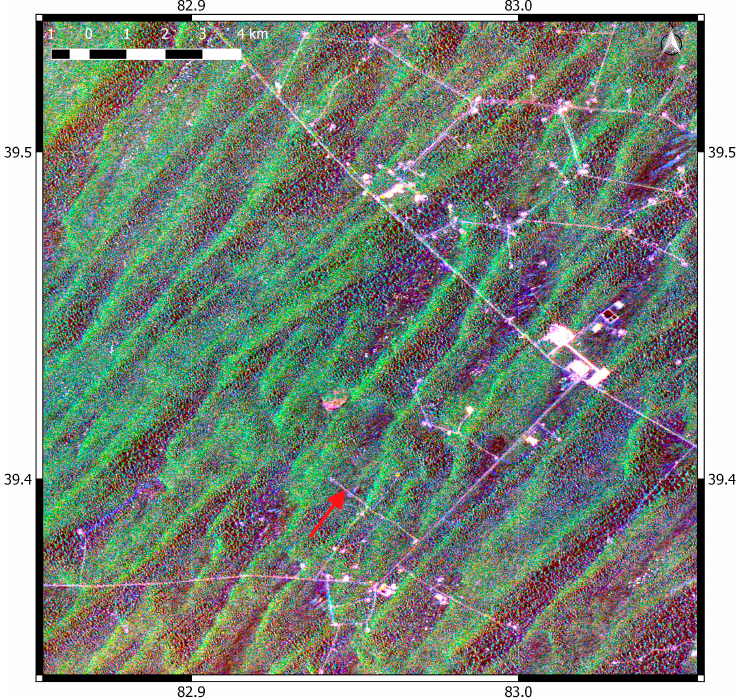
Figure 18. Sentinel–1 colour composite of time series averages of the VH backscatter in red, VV backscatter in green, and coherence in blue. This comprised the input to the model for the Taklimakan Desert area. The extent is the same as that for Figure 17. Contains modified Copernicus Sentinel data 2020.